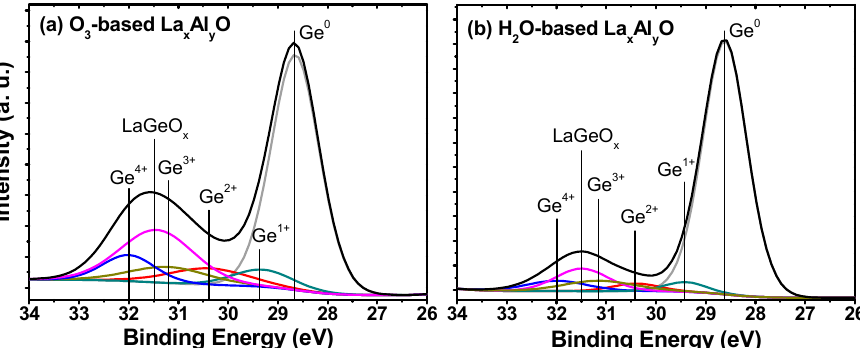
Figure 2. Shallow core-level spectra of Ge 3 d for the 5 nm ( a ) O 3 -based and ( b ) H 2 O-based La x Al y O films.